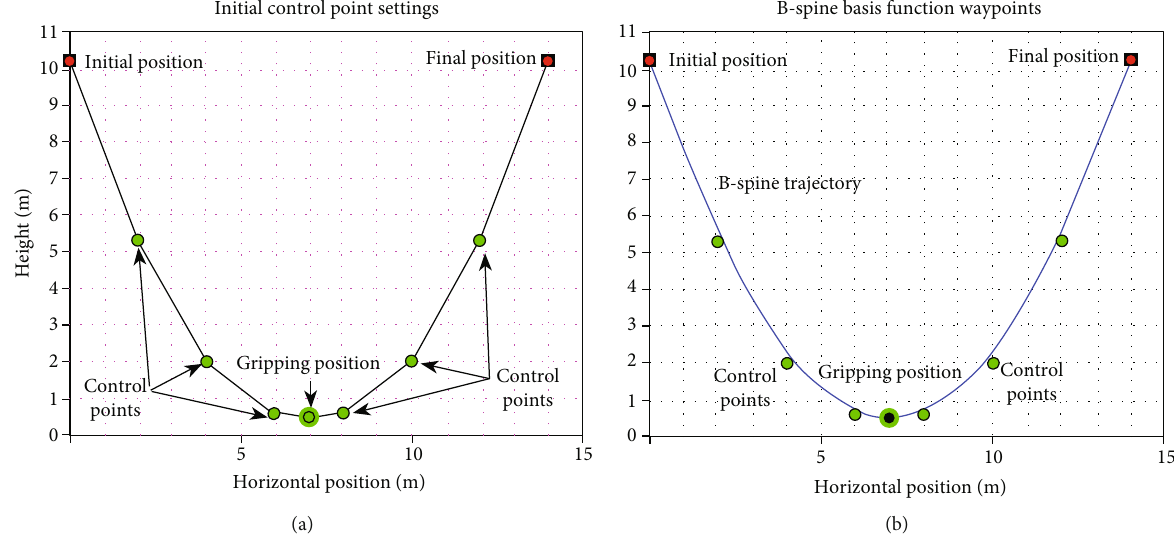
Figure 5: Location of the initial control node. (a) Initial control points choice. (b) B-spline basis function waypoints.